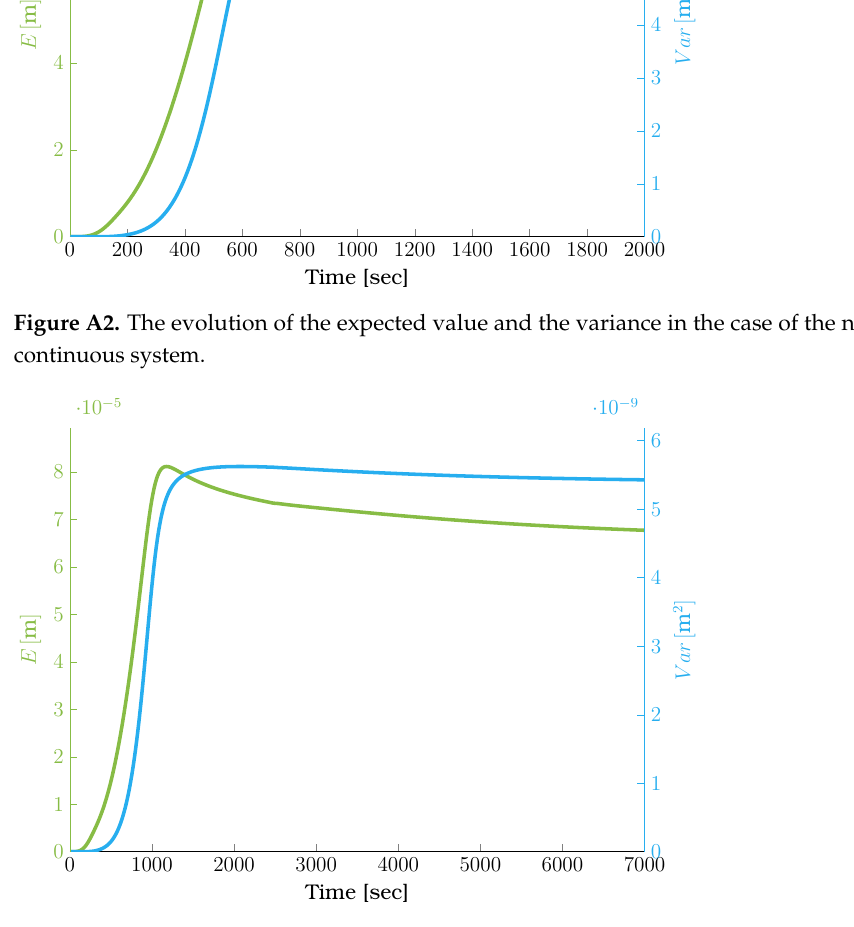
Figure A3. The change in the expected value and the variance in the case of the non-isothermal batch